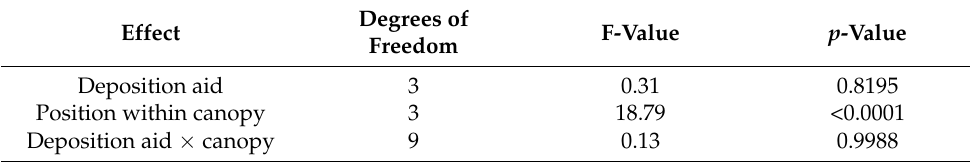
Table 2. Analysis of variance and associated p -values for deposition aids and canopy levels influenc- ing spray deposition on cotton. Data were pooled over years.